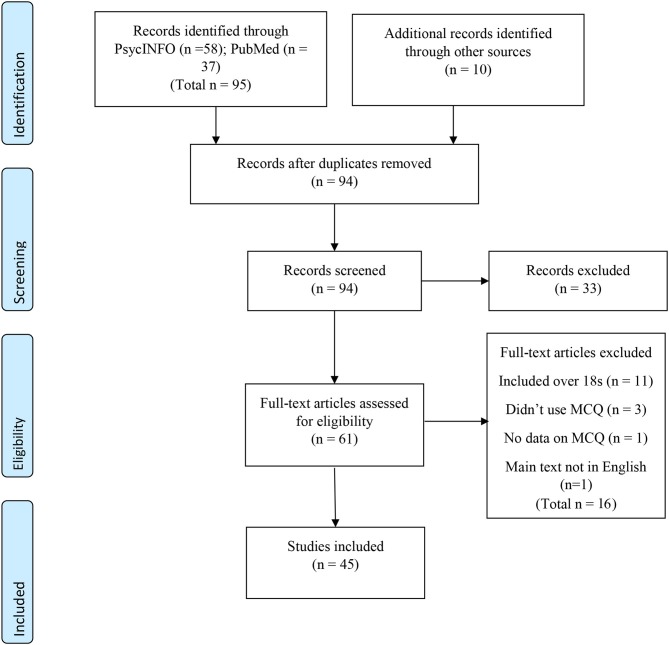
PRISMA diagram of search and study selection process.